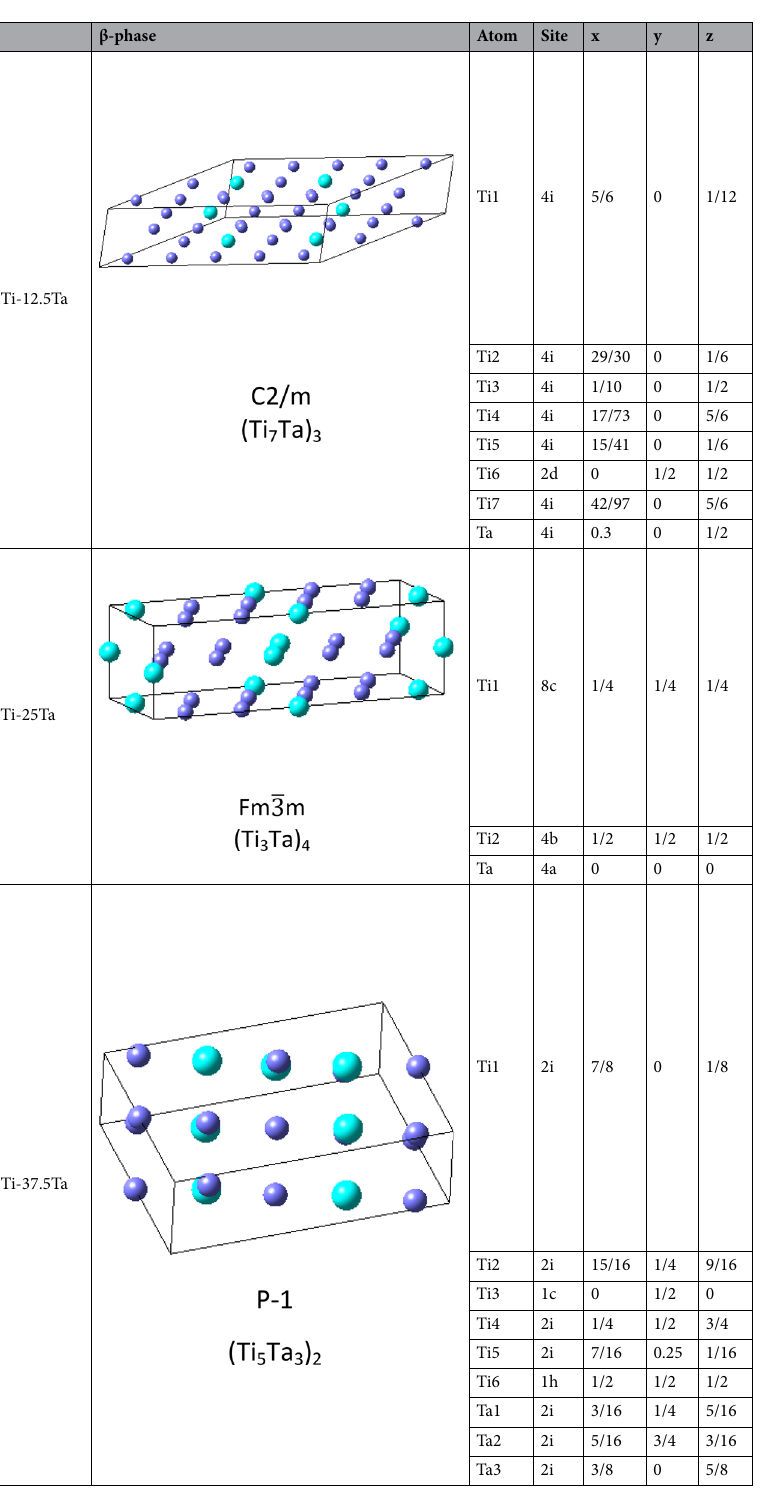
Table 4. CE predictions of stable β-phase structures in Ti–Ta binary. The blue and green atoms are respectively Ti and Ta